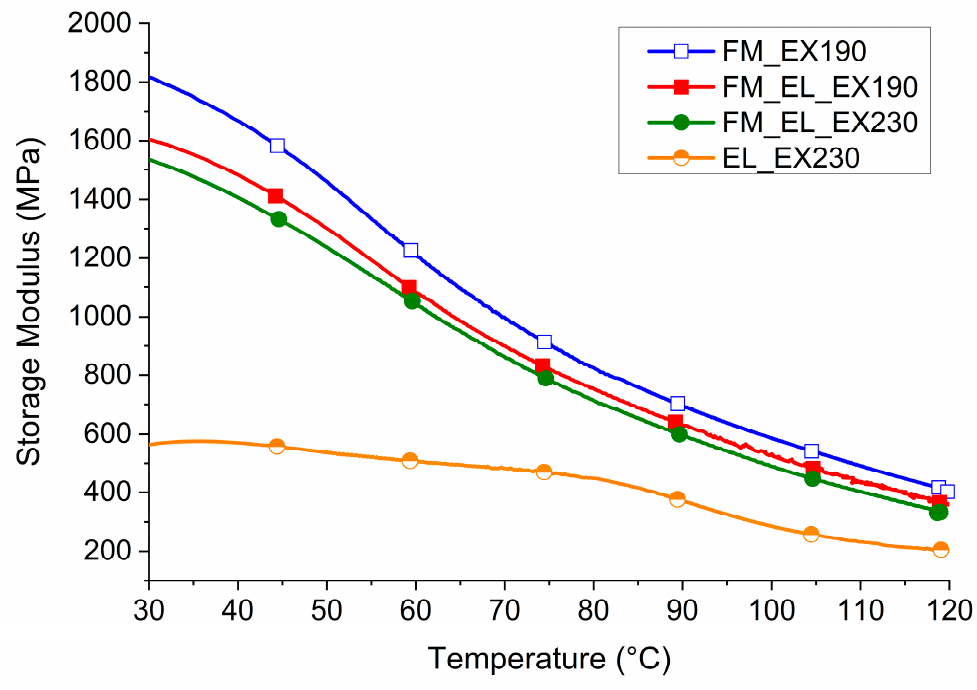
Figure 11. DMTA of FM_EX190, FM_EL_EX190, FM_EL_EX230, and EL_EX230.